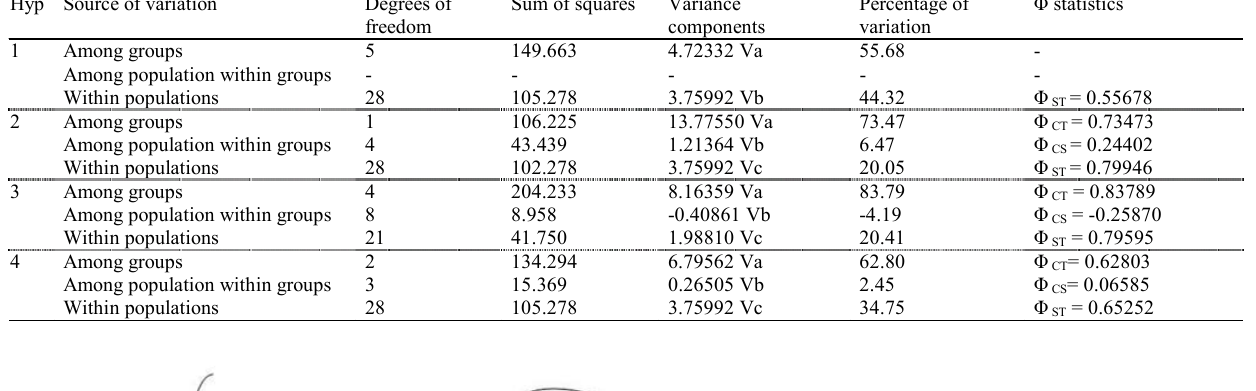
Table 5. Hierarchical partition of the variance components for Pimelodus albicans haplotypes under four different hypotheses: 1) a single group; 2) two groups including the río de la Plata samples and the río Arrecifes samples; 3) five groups according to present phylogeographic results; 4) three groups from río Arrecifes, locality 760, and remaining localities in the río de la Plata.